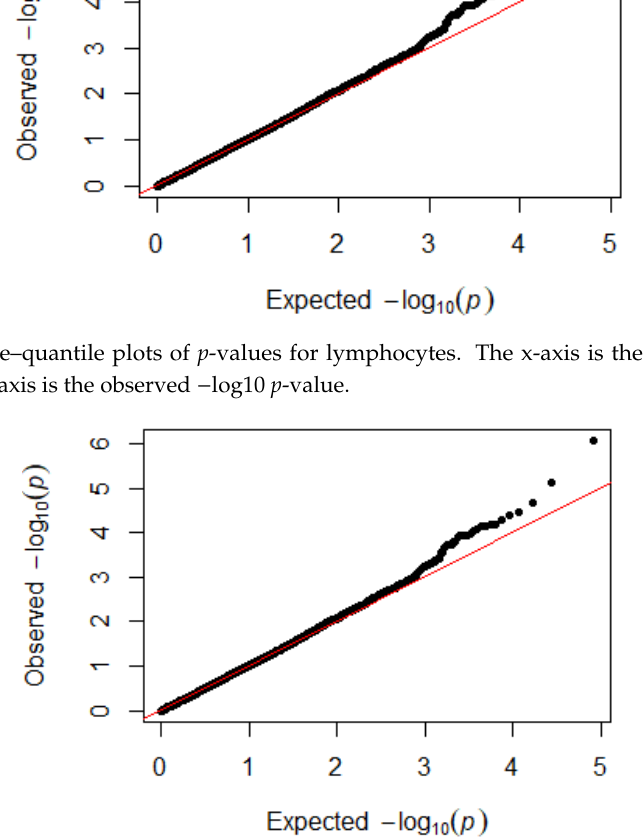
Figure 4. Quantile–quantile plots of p -values for monocytes. The x-axis is the expected − log10 p -value and the y-axis is the observed − log10 p -value.